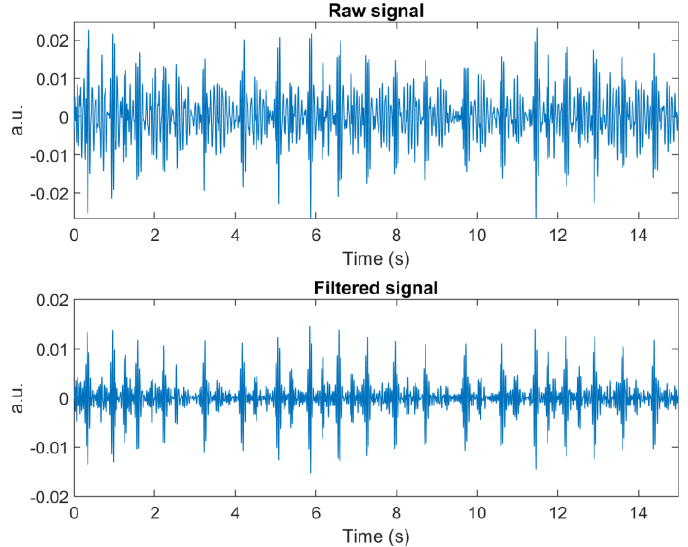
Figure 3. Raw signals ( top ) contained high frequency noise that blurred the systolic and diastolic parts in each cardiac cycle. Applying BPF with cut-off frequencies of 20 and 50 Hz improved the signal quality by removing high frequency noise and relatively low frequency oscillation between the two AOs ( bottom ).